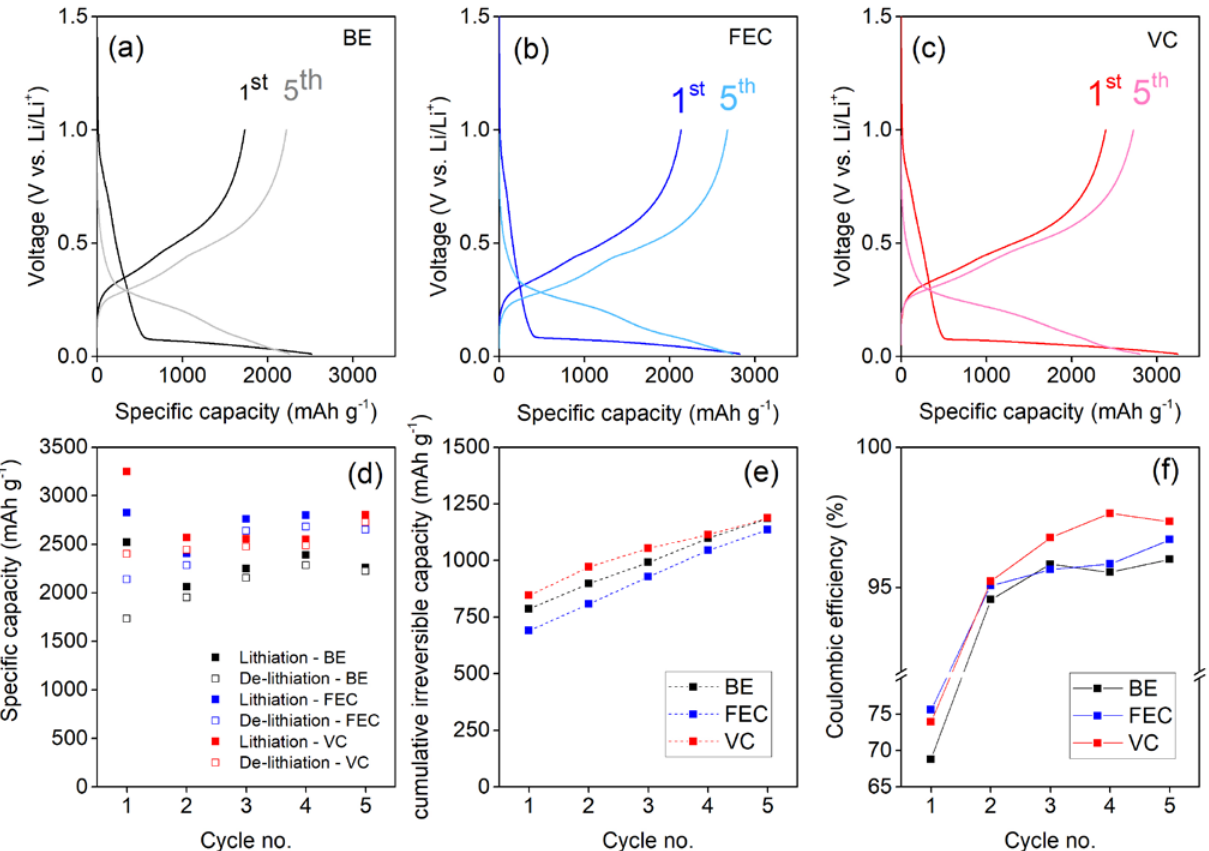
Figure 1. Discharge–charge cycling performance of Si NW electrodes at 0.2 C using: ( a ) the BE electrolyte; ( b ) the FEC added electrolyte; ( c ) the VC added electrolyte. ( d ) Specific capacity, ( e ) cumulative irreversible capacities in the first 5 cycles and ( f ) coulombic efficiencies.